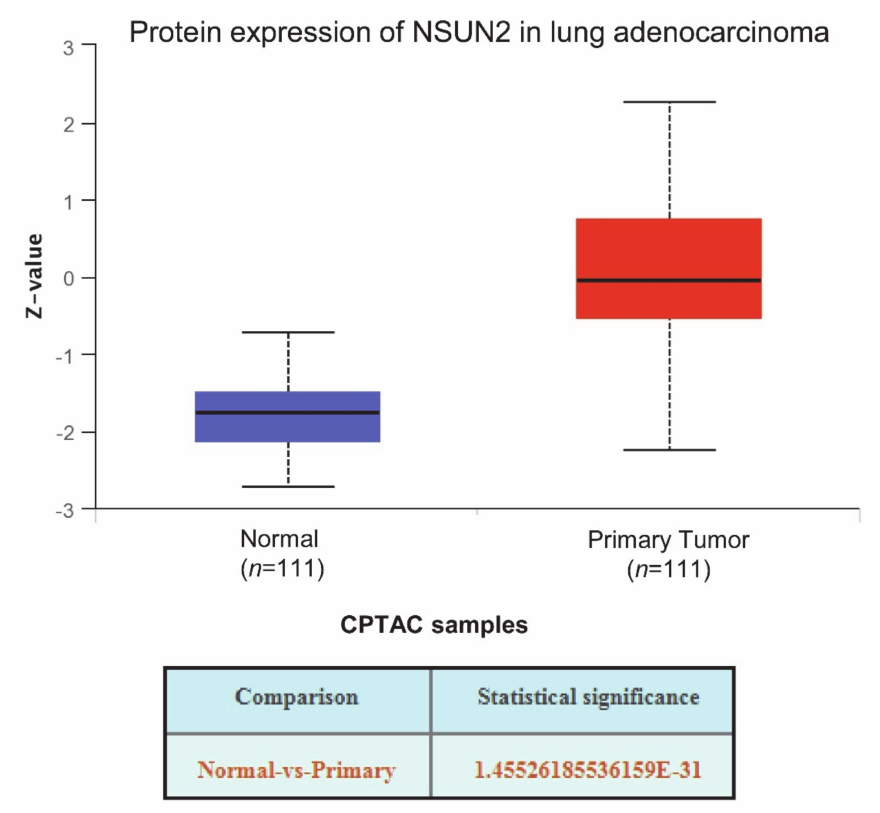
Figure 5. NSUN2 protein is overexpressed in LUAD samples: The expression of the NSUN2 protein was examined in the Clinical Proteomic Tumor Analysis Consortium (CPTAC) Confirmatory / Discovery dataset for LUAD using UALCAN [94]. Significant overexpression of NSUN2 protein was observed in tumors compared to normal